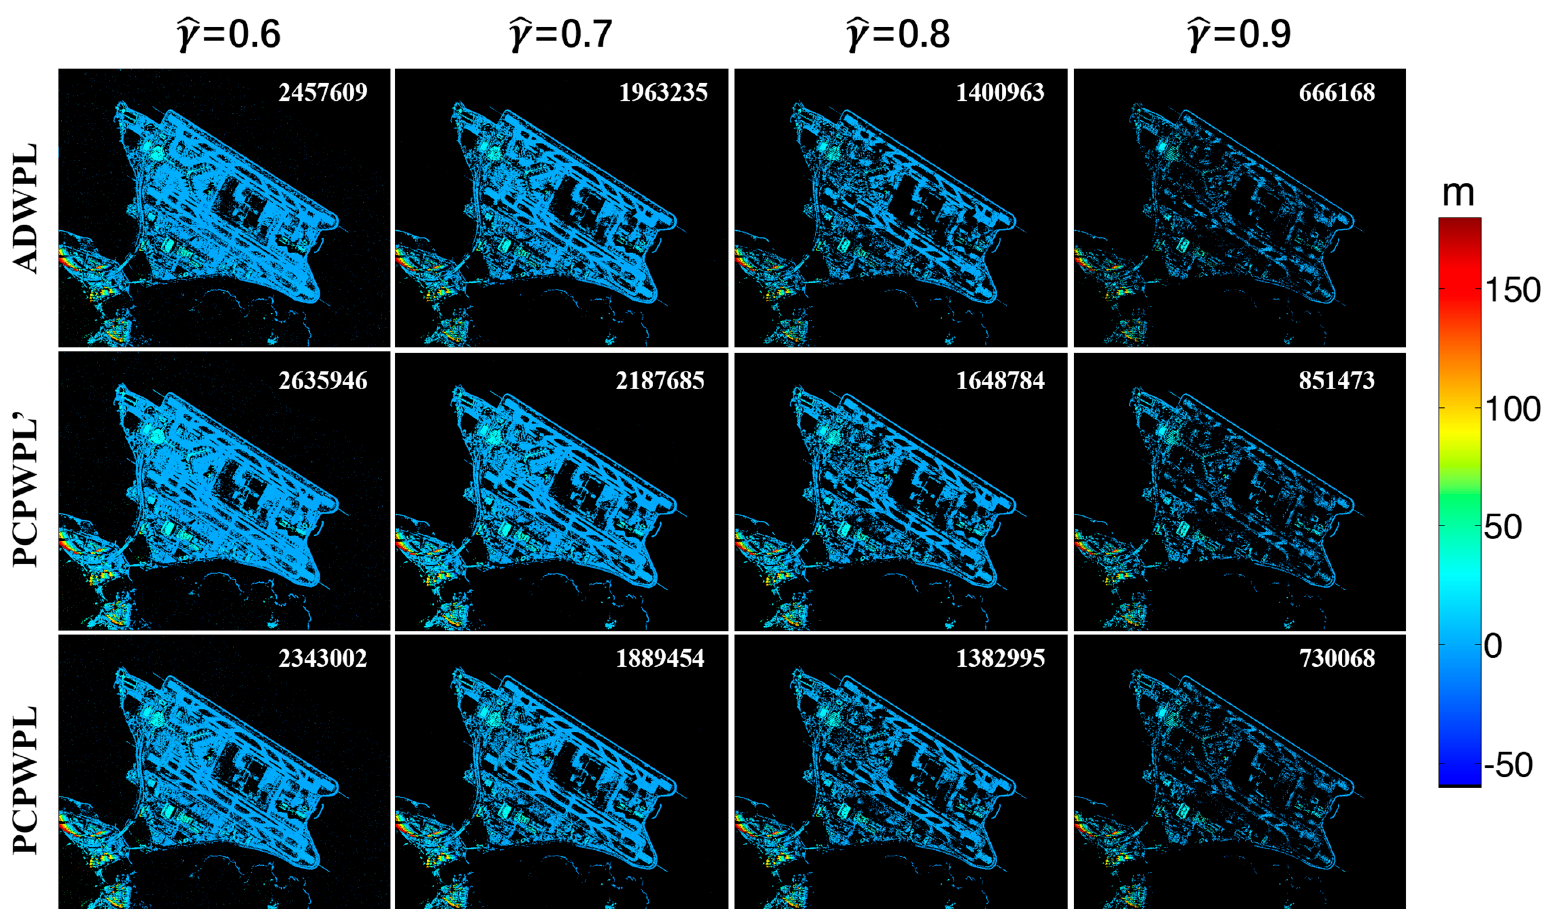
Figure 15. Qualified measurements (displayed in height) of HKIA under different coherence levels for DS extension, with their numbers of detected points annotated in top right.